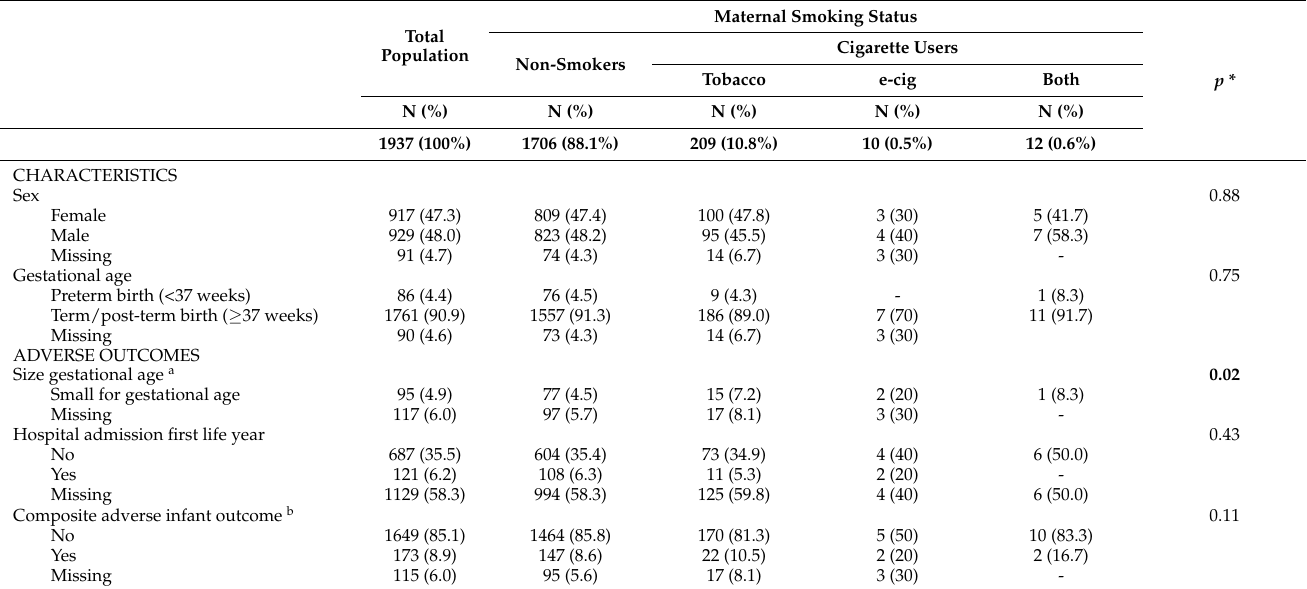
Table 3. Infant characteristics and outcomes by smoking